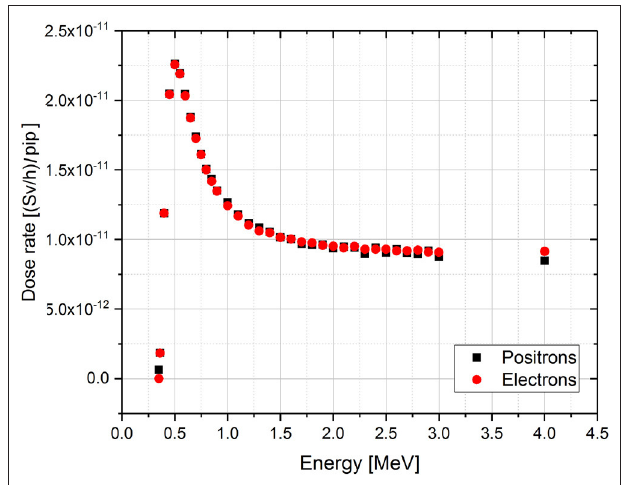
FIGURE 4 | Dose rate results of the MCNPX simulations for monoenergetic electron and positron sources per incident particle (pip). The simulated energy range goes from 0.36 to 4